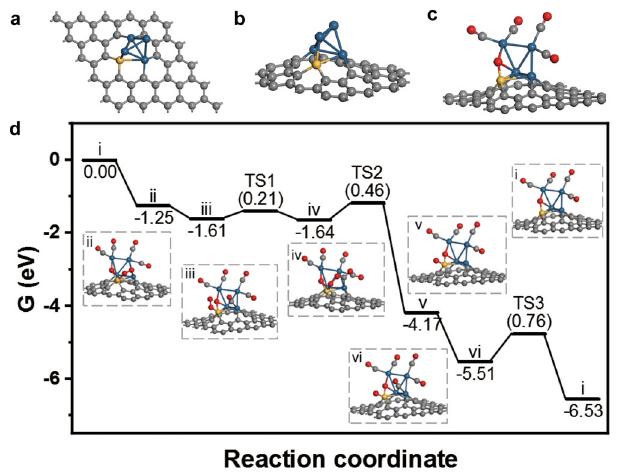
Fig.5|DFTcalculationsofCOoxidationon0.75Pt0.2Fe/ND@G.a Topviewand b sideviewoftheDFT-optimizedstructuresof0.75Pt0.2Fe/ND@Gafterreduction. c DFT optimized structure of Pt 4 Fe 1 O@Gr model. d Energy pro fi le of the CO oxi- dation on a